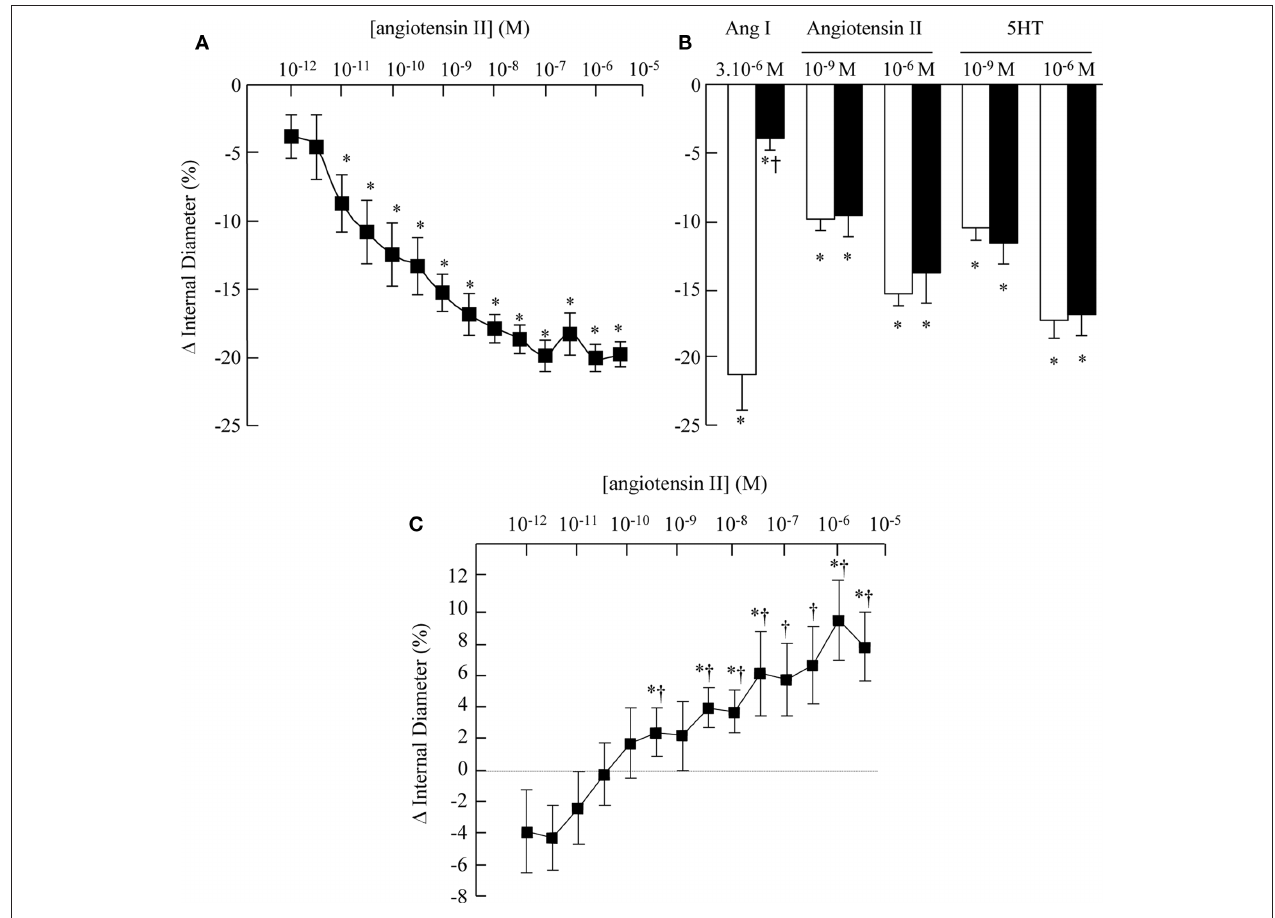
FIgure 2 | effects of angiotensins on cerebral arteriolar diameter (from Vincent et al., 2005). Cumulative concentration–response curve for arteriolar vasoconstriction evoked by angiotensin II [ (A) , n = 7], and effects of the ACEI, captopril (10 − 5 M, solid bar), on vasoconstriction induced by angiotensin I, angiotensin II, and 5HT [ (B) , n = 4]. Results are expressed as % fall in diameter. Values are mean ± SEM. * P ≤ 0.05 vs. baseline; † P ≤ 0.05